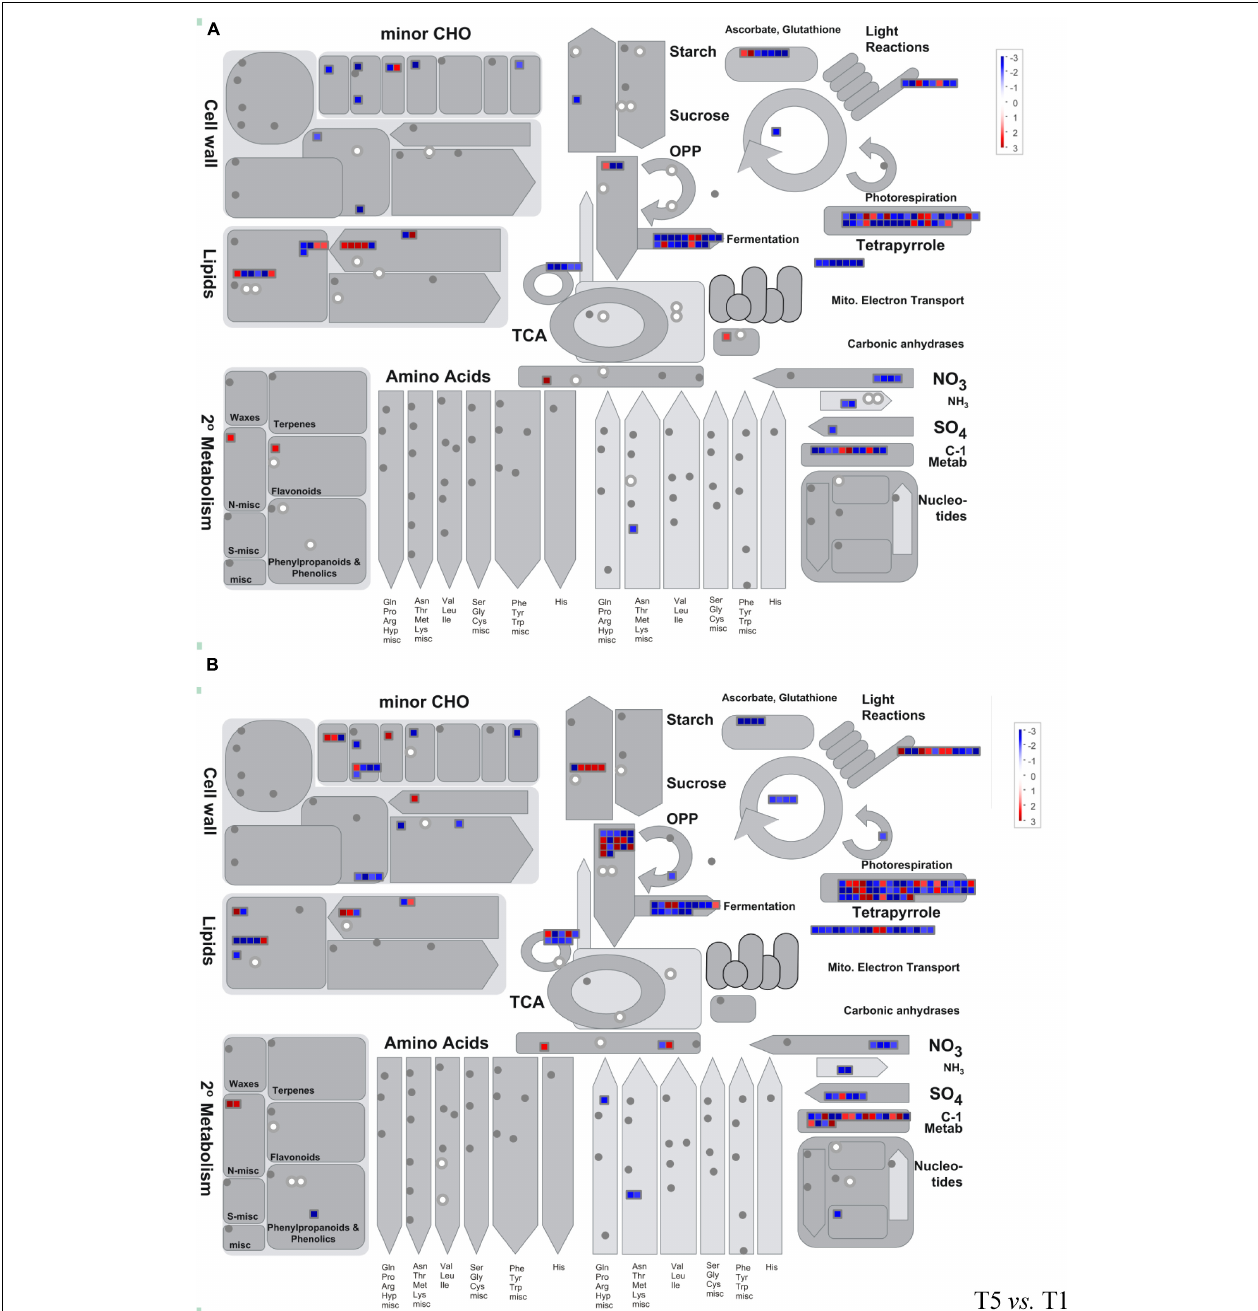
FIGURE 6 | Metabolism overview using MapMan. (A) T3 vs. T1; (B) T5 vs. T1. Genes and metabolites are represented by squares and circles, respectively. Color intensity corresponds to the expression ratio at the logarithmic scale (log2). Red: upregulated, blue: downregulated.